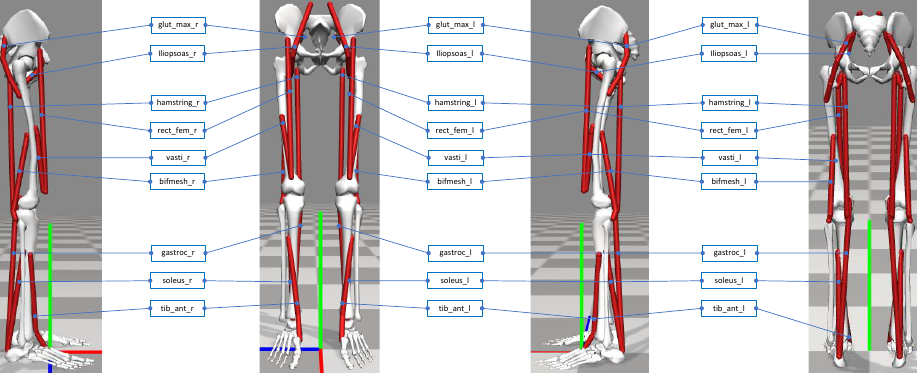
Figure 2. The physics-based human musculoskeletal model developed in this study. Figures from left to right: side view facing the right leg, front view, side view facing the left leg, and back